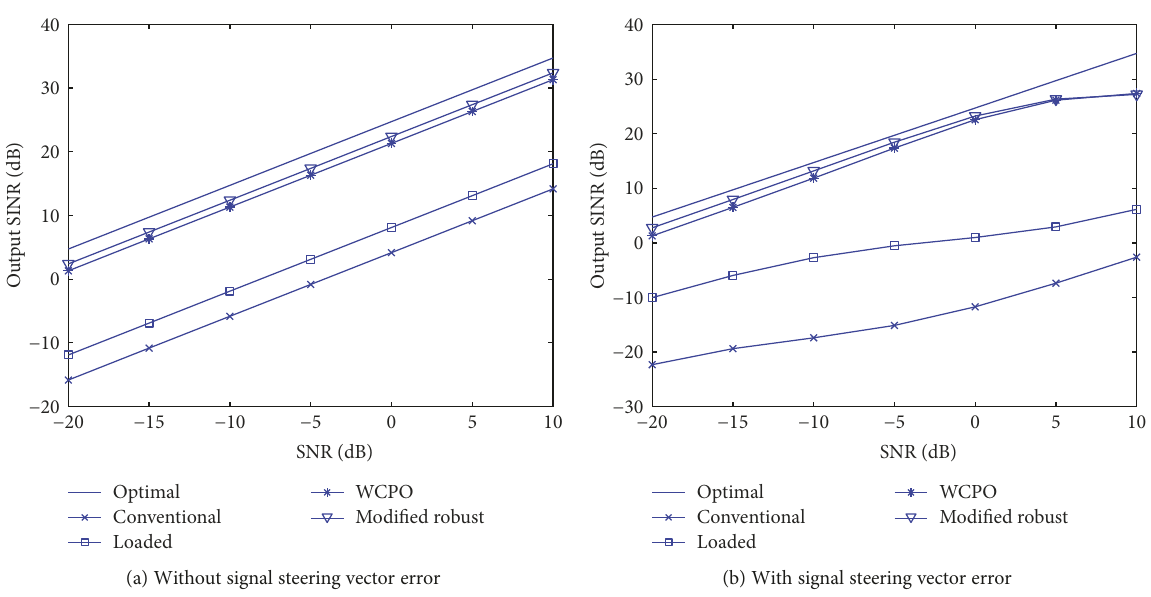
Figure 4: Output SINR versus input